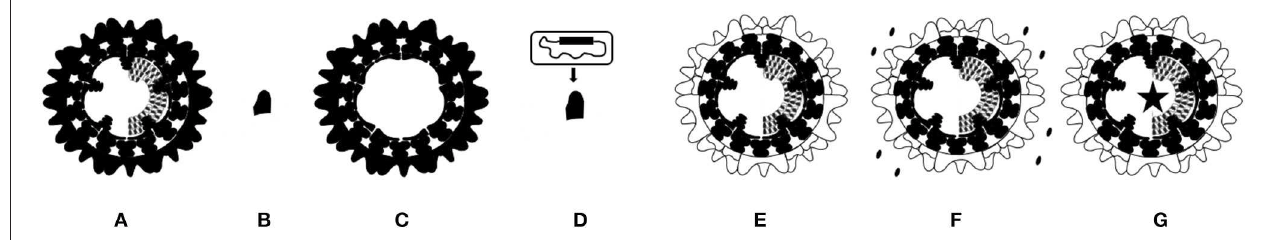
FIGURE 3 | Schematic representation of marketed and experimental BT vaccines. (A) Marketed vaccine is based on entire live-attenuated or inactivated BTV. (B) Subunit vaccine is based on BTV protein(s) produced in artificial systems, and mostly contains the here presented serotype specific outer shell VP2 protein. (C) VLP vaccine consists of empty virus particles produced in artificial systems consisting of BTV proteins VP2, 3, 5 and 7. (D) Viral vector vaccine is nonBT-virus expressing one or more BTV proteins. Here, a VP2 expressing viral vector vaccine is presented. (E–G) The exchanged serotype specific outer shell proteins VP2 and VP5 are indicated (white). (E) “Serotyped” LAV and inactivated BT vaccine are based on a common LAV or a production BTV backbone, respectively. (F) DISC vaccine lacks expression of an essential BTV protein, and must be produced by in trans complementation as indicated. (G) DISA vaccine and NS4 knockout vaccine lacks expression of nonessential NS3/NS3a or NS4, respectively